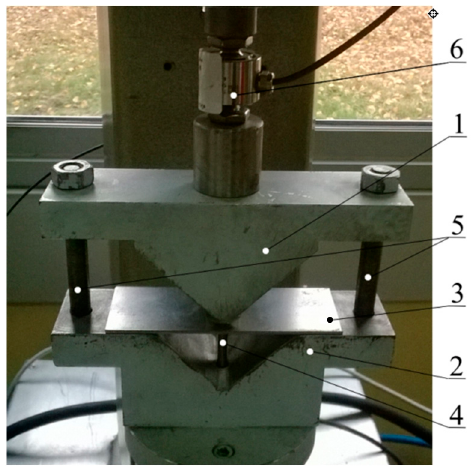
Figure 2. The experimental setup: 1—punch; 2—die; 3—sample; 4—punch stroke controller; 5—guide columns; and 6—force transducer.